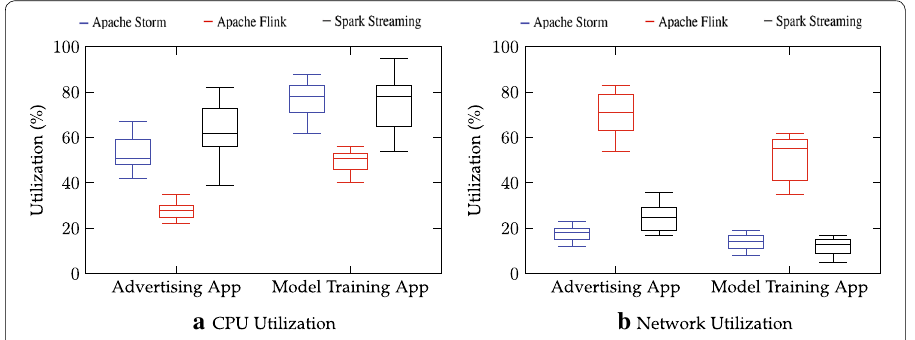
Fig. 19 Resource usage for both Advertising and Model Training applications running on 8 worker